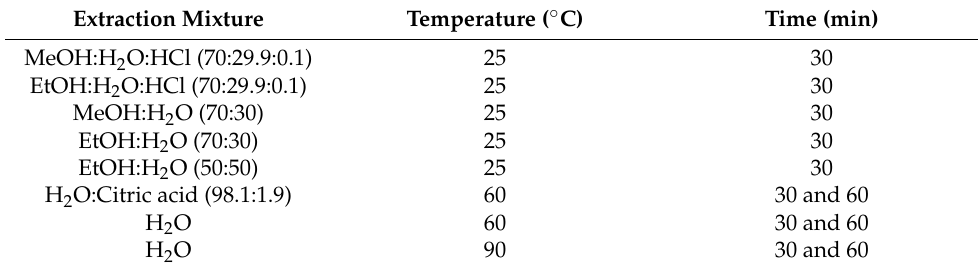
Table 1. Extraction conditions of the olive leaf extracts. Extraction